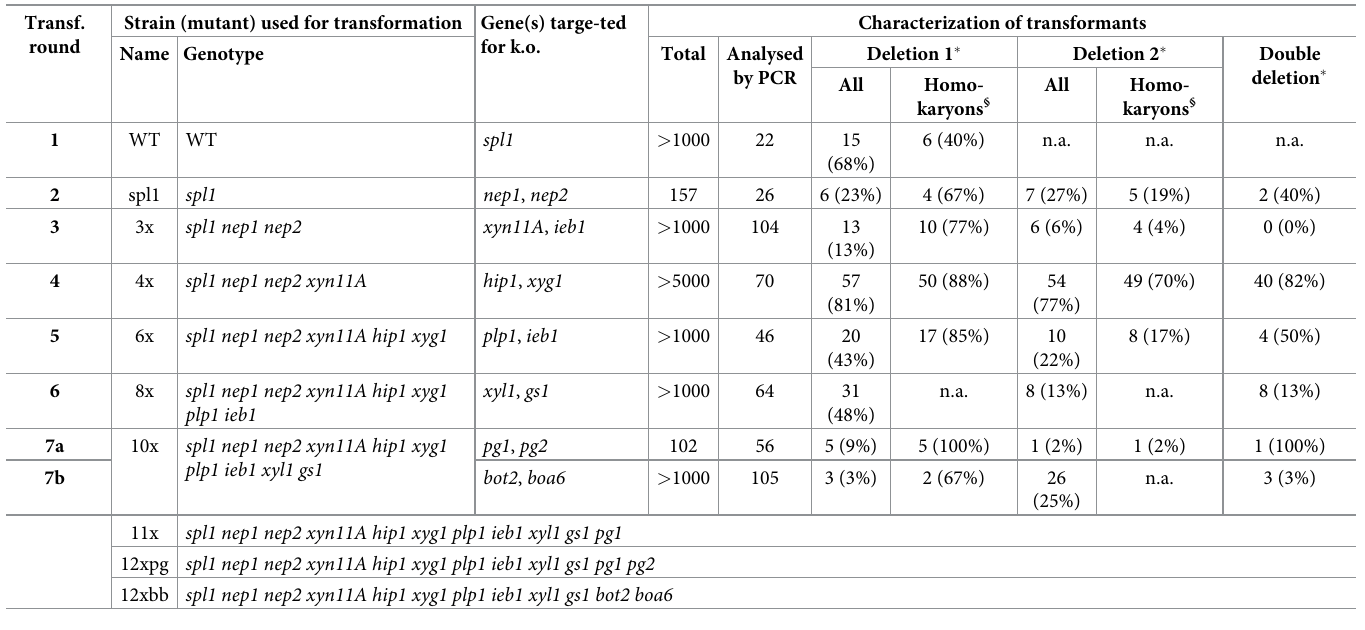
Primary transformants showing the expected deletion and no evidence for remaining WT DNA by PCR, when using primers A1/A2 (see S2